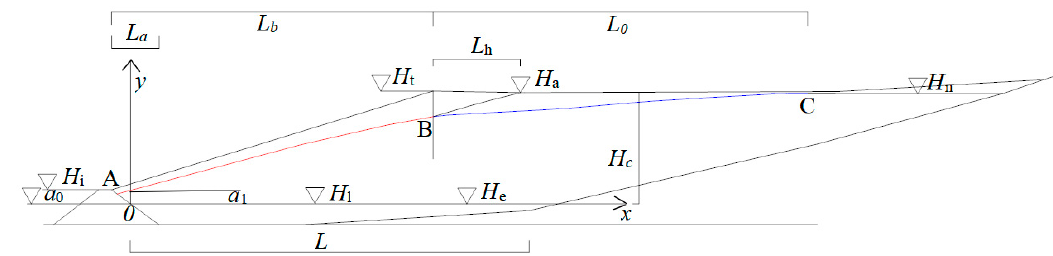
Figure 4. Diagram for calculating the tailings dam’s phreatic line. H i is the starter dam elevation; H t is the tailings dam elevation; H n is the normal reservoir water level; H a is the corrected amendatory reservoir water level; H e is the water inlet elevation; H l is the long-term eliminating seepage elevation; H c is the calculated water head; L is the seepage length; L a is the upstream projected length of the started dam; L b is the distance between the starter dam and the tailings dam; L 0 is the length of dry beach face; L h is the corrected length of dry beach face; a 0 is the water overflow height; a 1 is the intercept of the phreatic line on the y-axis; A, B, and C is the intersection of the curve at the corresponding position in the graph.